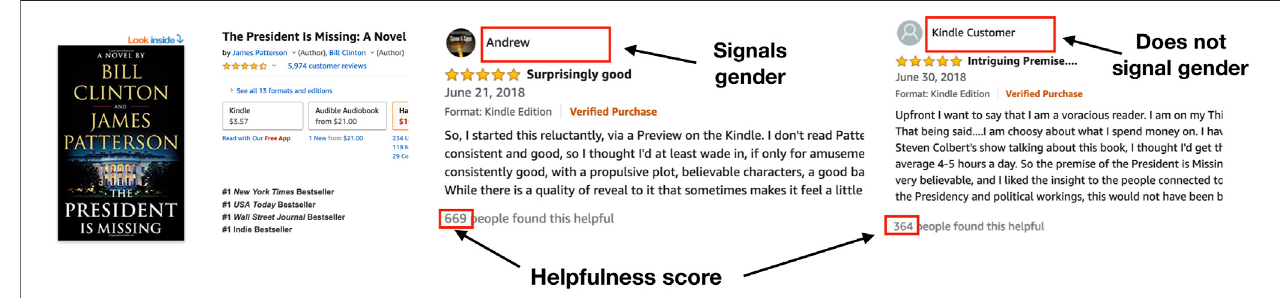
FIGURE1| Illustration:Considerthereviewswrittenfortheproduct “ ThePresidentisMissing:ANovel. ” Theauthorofthereviewontheleftsignalsalikelygenderby the user name “ Andrew. ” On the right the author ’ s user name “ Kindle Customer ” does not signal a likely gender. Further, the perceived helpfulness of a review can be quanti fi ed by the helpfulness score of the review. We explore whether signals of the gender of the authors in fl uences the perceived helpfulness of a